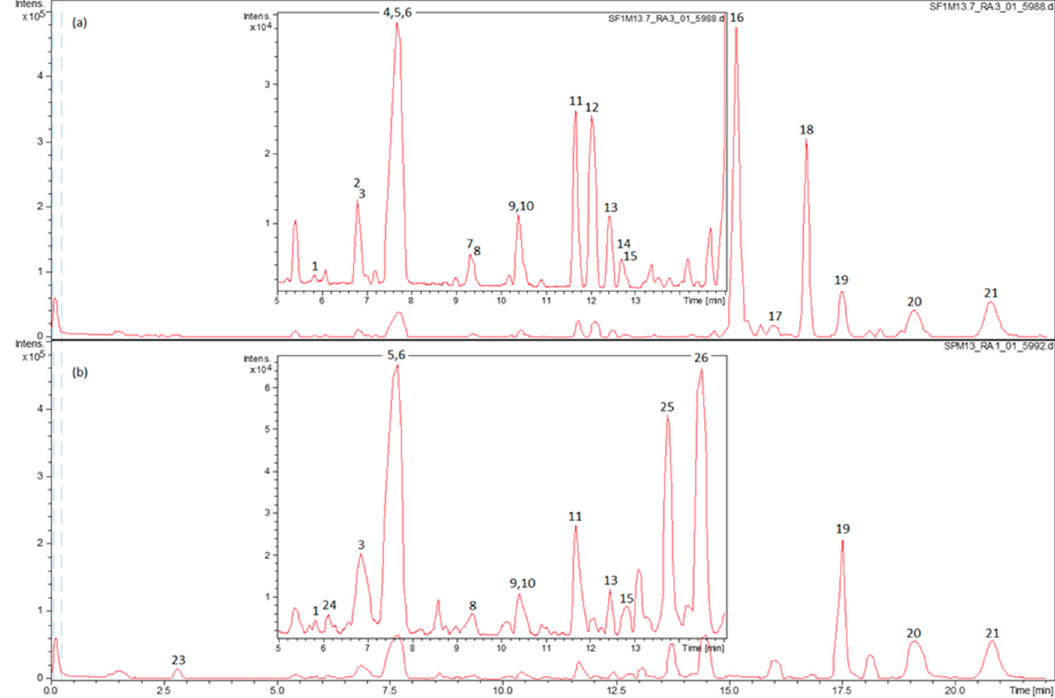
Figure 2. The base peak chromatograms (BPC) of methanolic extract of ( a ) Salvia fruticosa and ( b ) Salvia pomifera .